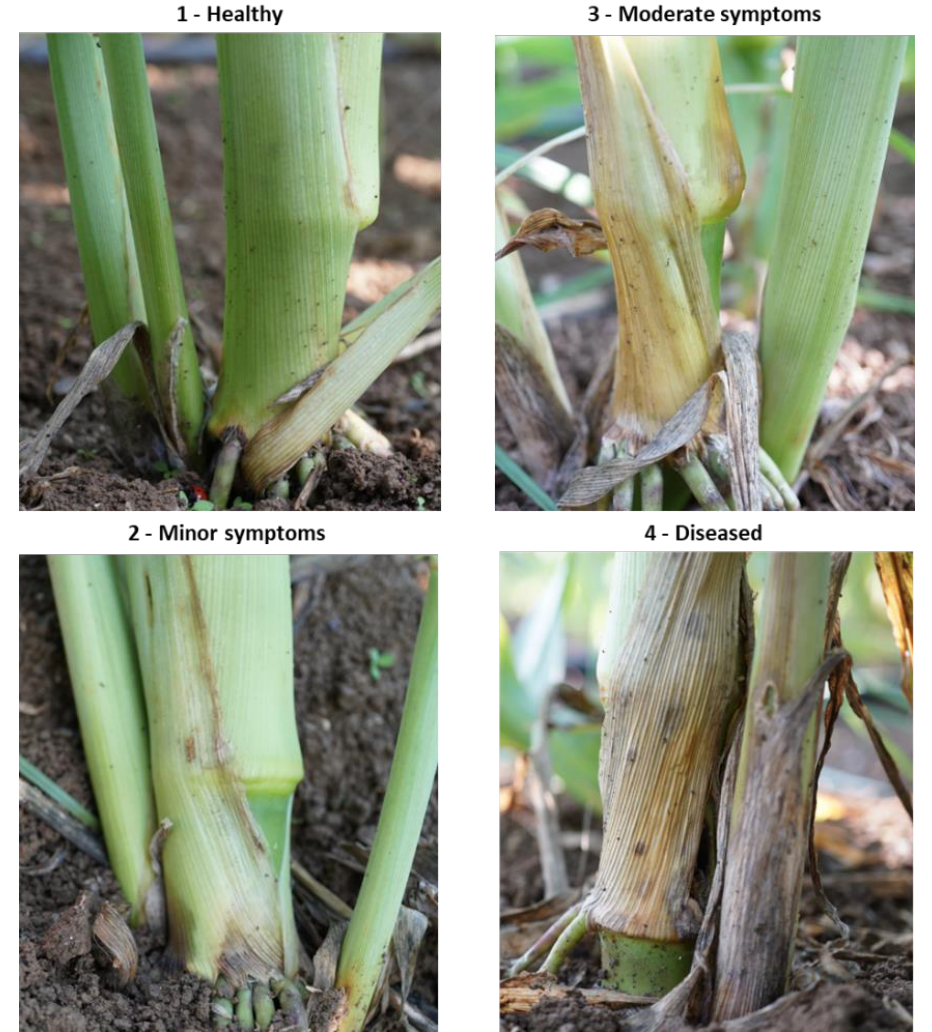
Figure 2. Classification of the lower stem (first aboveground internode) disease symptoms at the end of the 2020 field experiment (82 DAS). Representative images that are showing increasing degrees of late wilt symptoms. Symptoms were analyzed using four categories: healthy (1), minor symptoms (2), moderate symptoms (3), and diseased